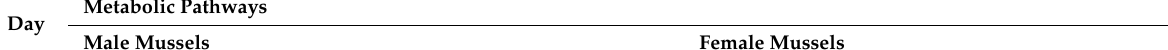
Table 2. Impacted metabolic pathways over time, sorted by decreasing p -value. When a group of related pathways was impacted more than one day or in one sex, it was attributed a number in brackets. Pathways in italics are specific to male mussels while bold pathways are specific to females. *: significantly impacted pathways; †: pathways that tended to be